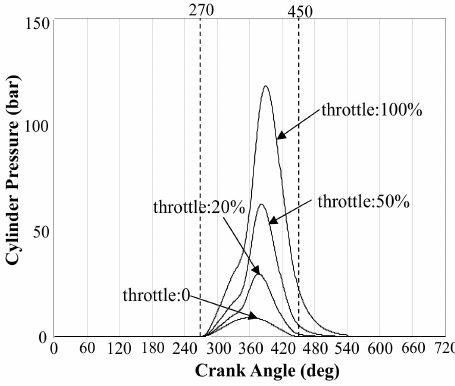
Figure 4. Indicator diagram in different throttle position at 1000 rpm.